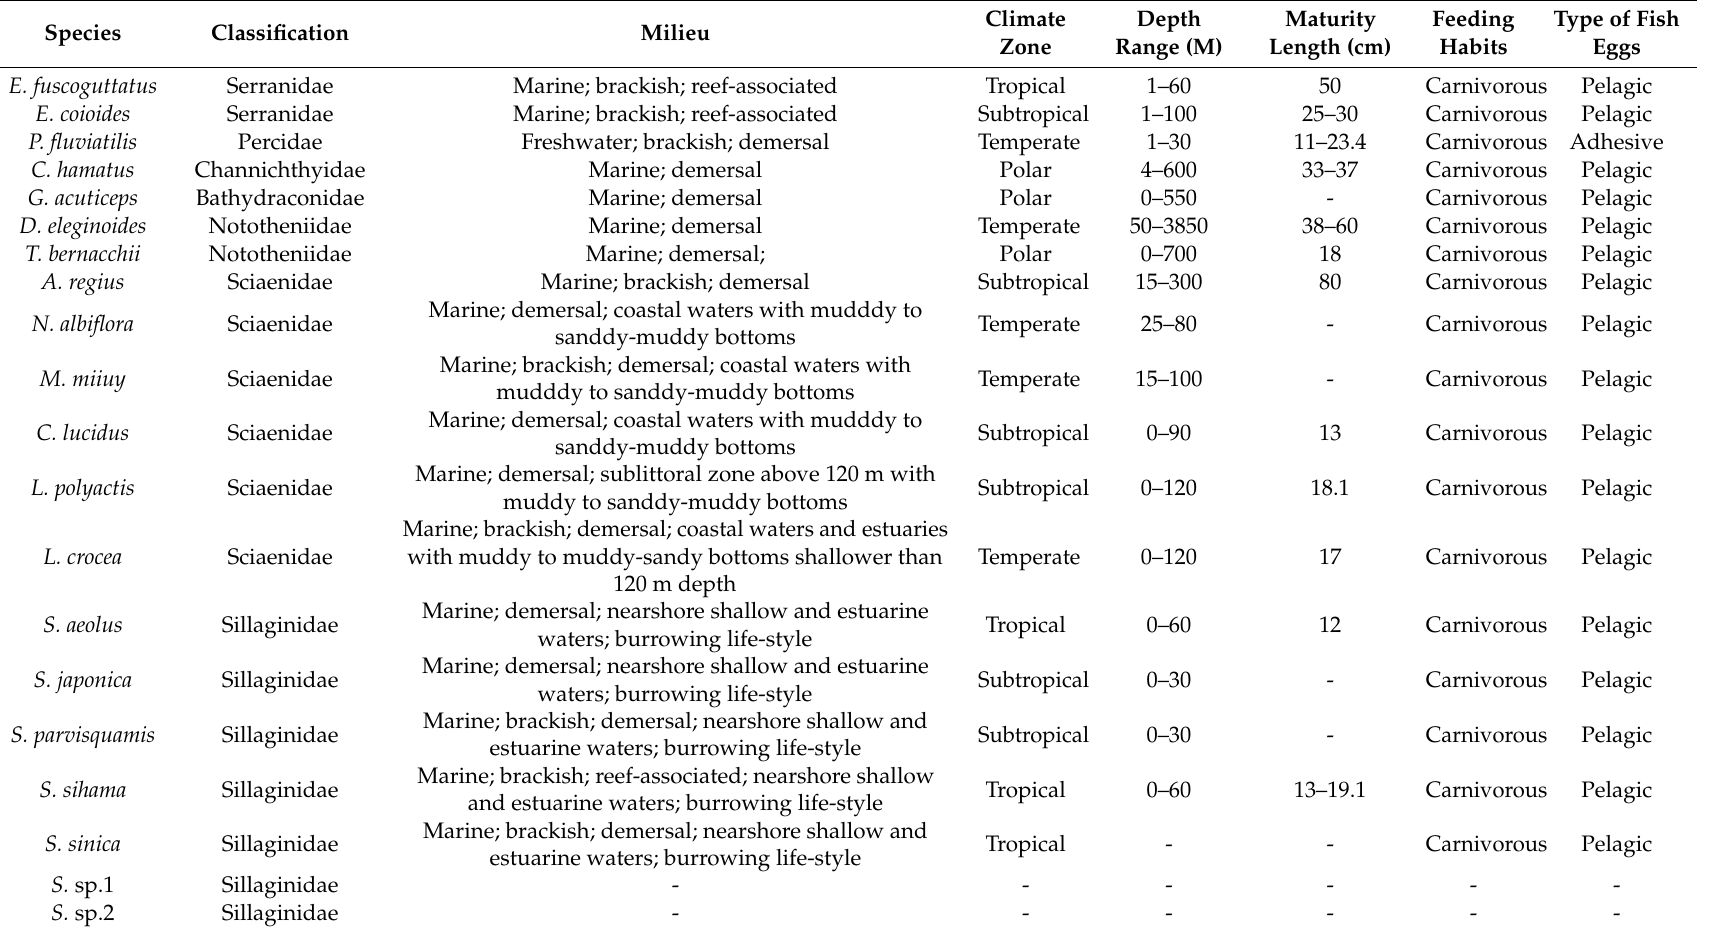
Table 1. The ecological characteristics of 20 research